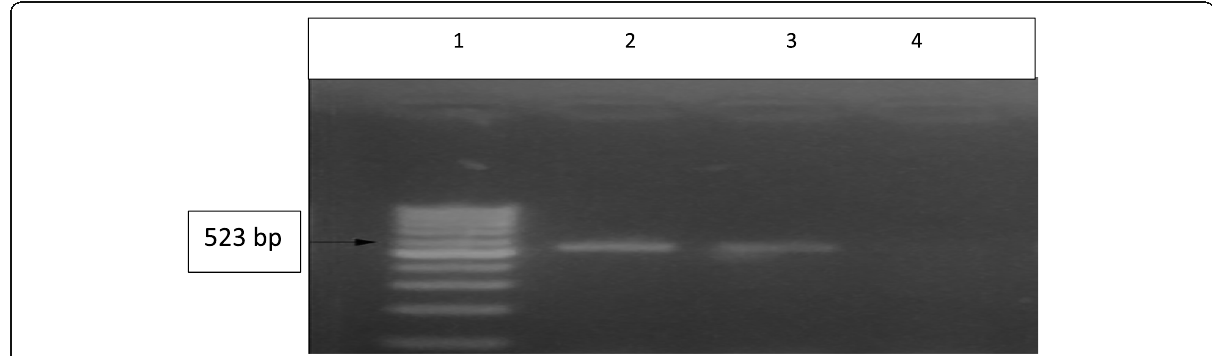
Fig. 2 Agarose gel electrophoresis of amplified product AME gene generated by PCR assay. Lane 1: molecular weight marker (ladder 100 bp); lanes (2 and 3): aph (3 ′ )-IIIa positive (523 bp); lane (4): negative